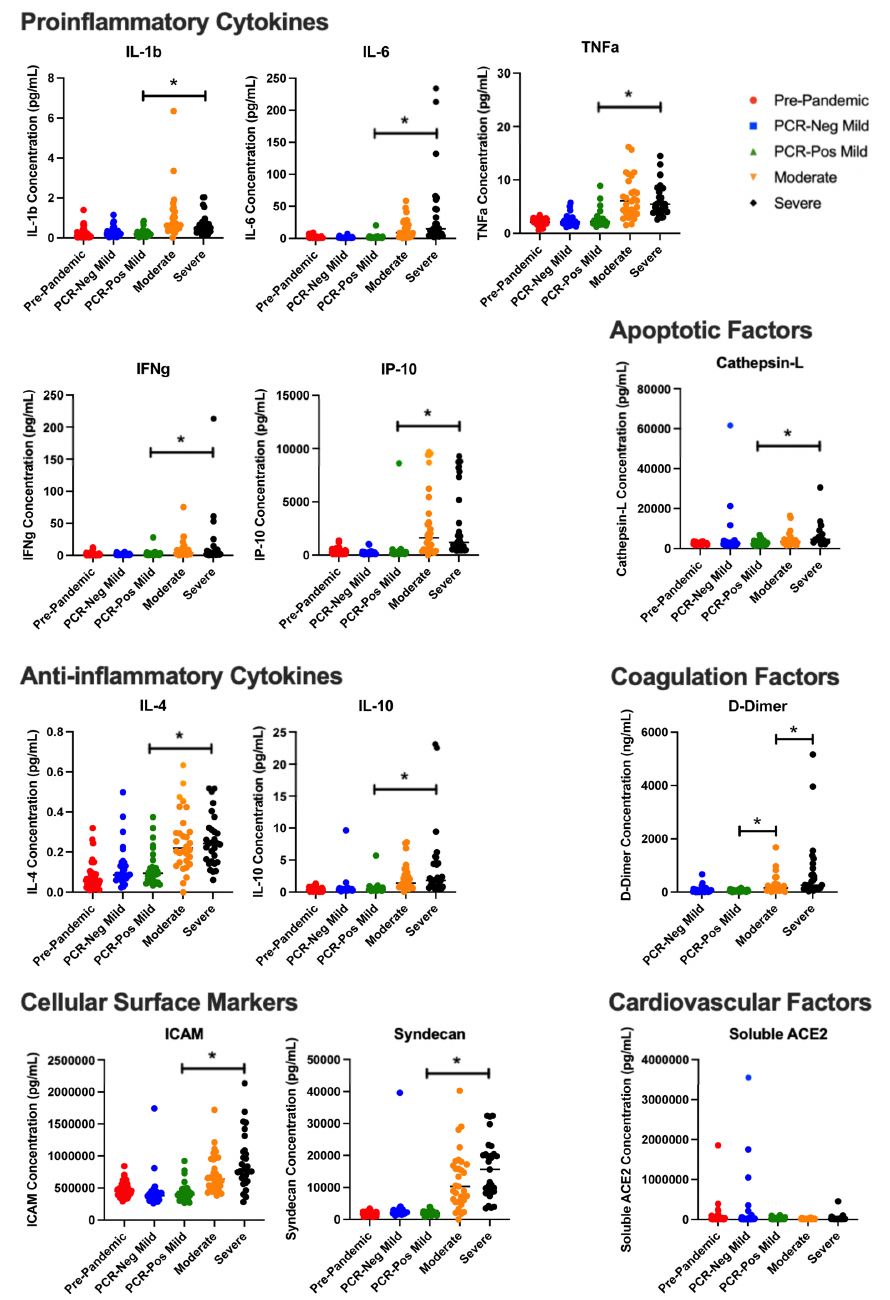
Figure 3. Inflammatory markers across disease severity. Dot plot representation of cytokine, coagulation factors, cell surface markers, cardiovascular and apoptotic factors, across disease severity cohorts. IFNγ, TNFα, IL-1β, IL-4, IL-6, IL-10, IP-10, ICAM, Syndecan, Cathepsin-L, and D-Dimer statistically significantly differed between PCR-positive non-hospitalized (mild disease) and PCR-positive hospitalized (moderate and severe disease) cohorts (*: P < 0.05). D-Dimer also significantly differed among hospitalized moderate and severe COVID-19 disease groups ( P <